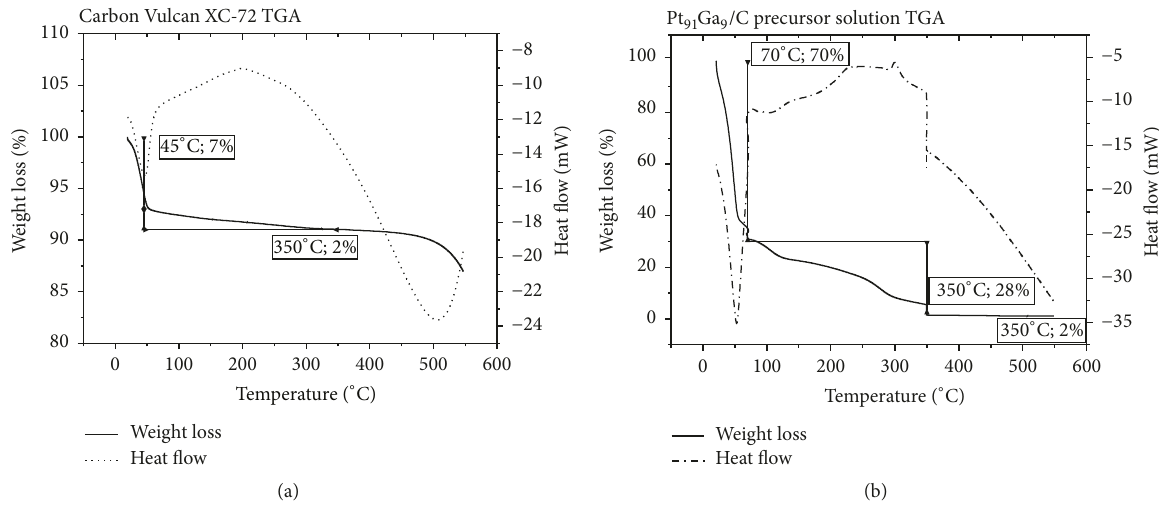
Figure 2: TGA and DTA curves obtained for (a) carbon Vulcan XC-72 and for (b) precursors solution of Pt 91 Ga 9 /C electrocatalyst with isotherm at 70 ∘ C and 350 ∘ C, for 10 min and 180 min, respectively, both at heating rate of 5 ∘ Cmin −1 from room temperature to 550 ∘ C.